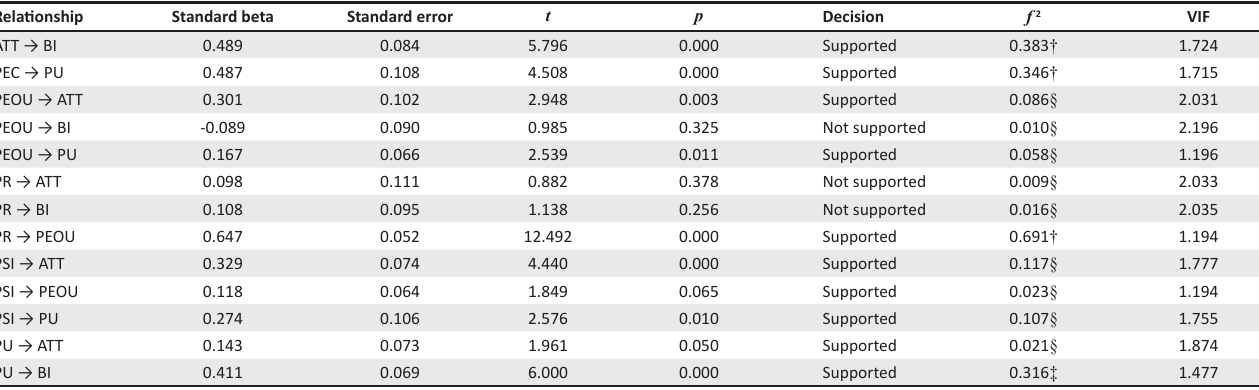
TABLE 3: Path coefficient. Relationship